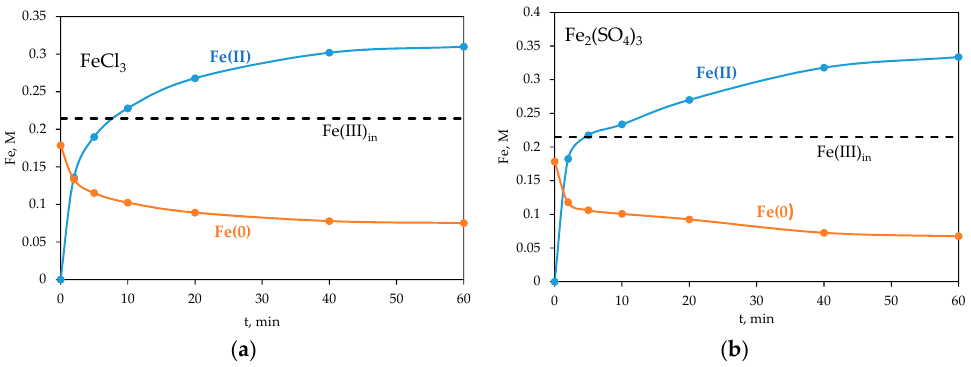
Figure 2. Evolution of Fe(II) concentration and depletion of Fe(0) in the experiments carried out at pH 0.5 for ( a ) FeCl 3 and ( b ) Fe 2 (SO 4 ) 3 solutions.